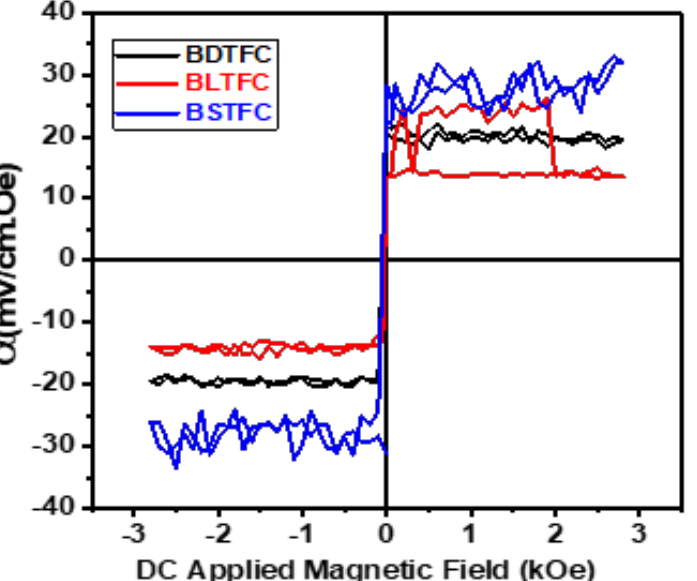
Figure 9. Magnetic field dependence of the magnetoelectric (ME) coefficient at room temperature for BDTFC, BSTFC, and BLTFC samples.